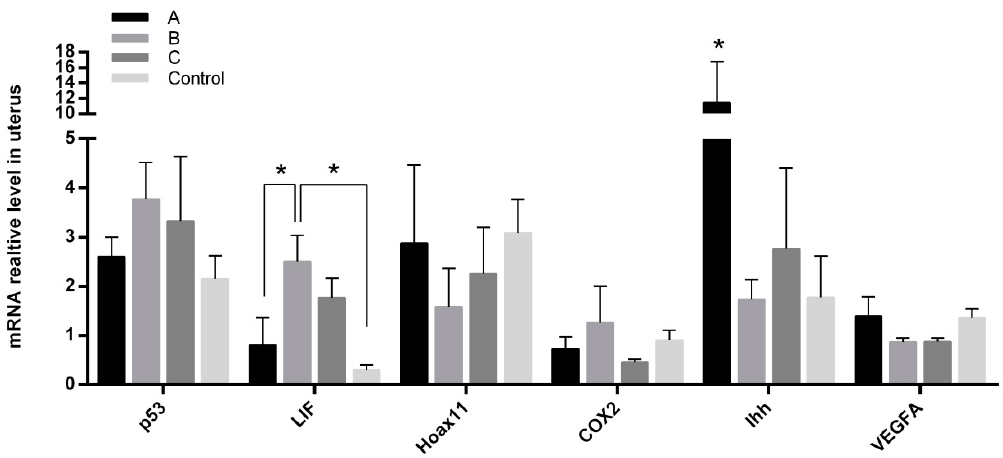
Figure 6. The mRNA levels of p53 , LIF , Hoxa11 , COX2 , Ihh , and VEGFA in endometrium of 7.5 day pregnant mice. Mice were treated with melatonin (4.3 μ g/mL) in drinking water. A, melatonin was given 14 days before mating (vaginal plugs were detected); B, melatonin was given from the mating to the delivery; C, melatonin was given from 14 days before mating to the delivery; Control: without melatonin. The experiment was independently repeated four times. “*” represents a significant difference of these columns ( p < 0.05).